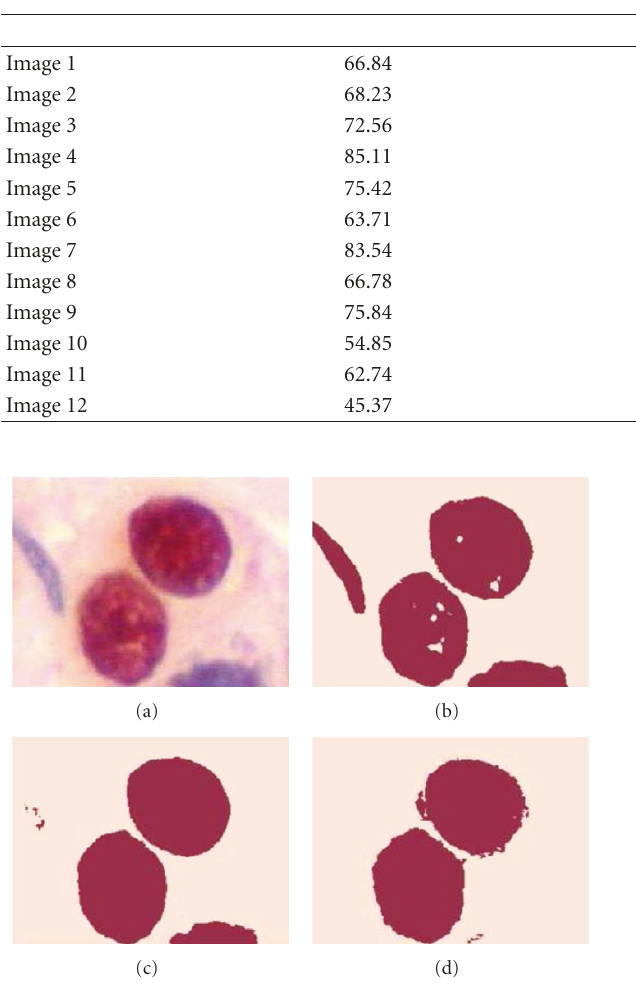
Figure 2: Segmentation results on a colour image. (a) Original image (256 × 256 × 3) with gray level spread on the range [0,255]. (b) Red resulting image by homogeneity histogram-based method. (c) Green resulting image by homogeneity histogram-based method. (d) Blue resulting image by homogeneity histogram-based method. The selected thresholds are 147, 110, and 194, respectively.